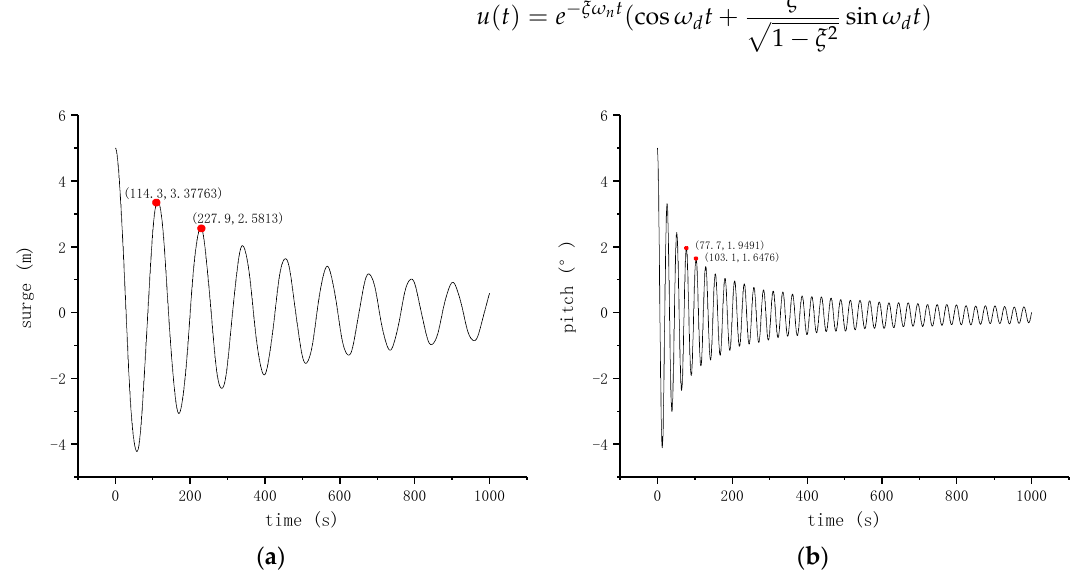
Figure 17. Free decay response. ( a ) Surge motion; ( b ) pitch motion.